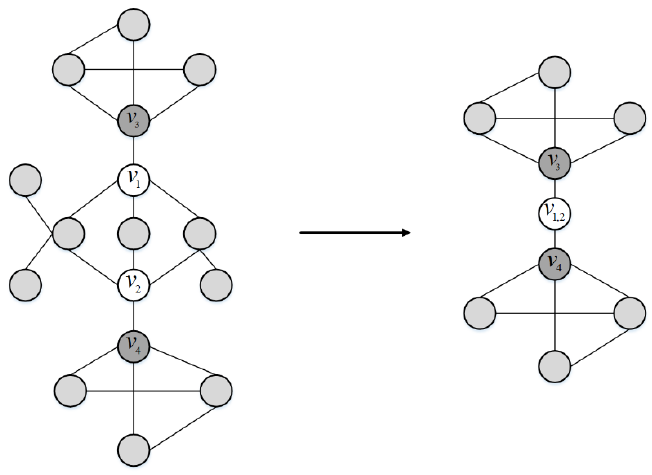
Figure 3. Example of network graph layering.